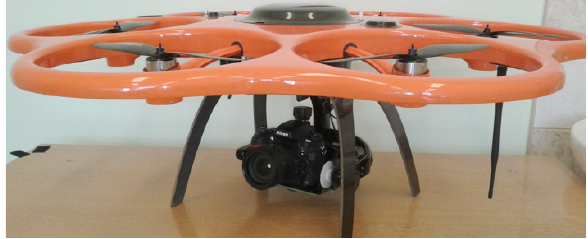
Figure 2 . Aibot X6 V2 with Nikon D800 camera.